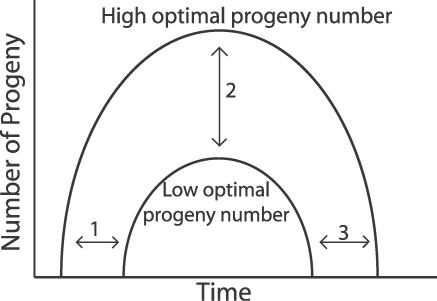
Reproductive Aging Contributes to the Ability of Animals to Generate the Optimal Progeny NumberHypothetical progeny production curves illustrate three mechanisms for controlling progeny number: the timing of the onset of progeny production (labeled 1), the level of steady-state progeny production (labeled 2), and the timing of cessation of progeny production or reproductive aging (labeled 3). Reproductive aging might be sculpted during evolution by selection for animals that generate the optimal number of progeny.